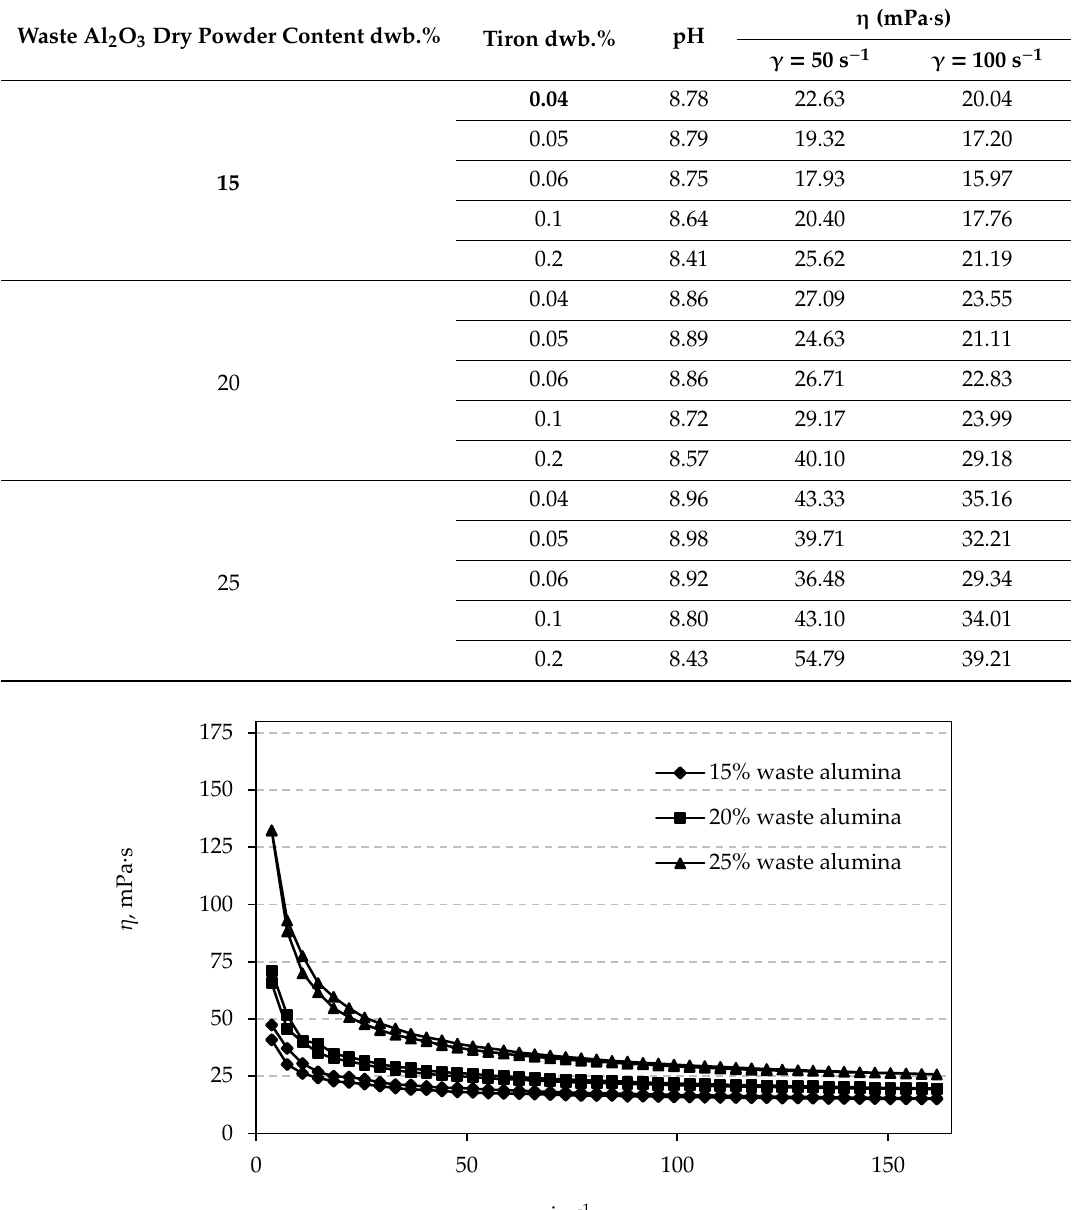
Table A2. Measured apparent viscosity of all prepared suspensions. Waste Al 2 O 3 Dry Powder Content dwb.%